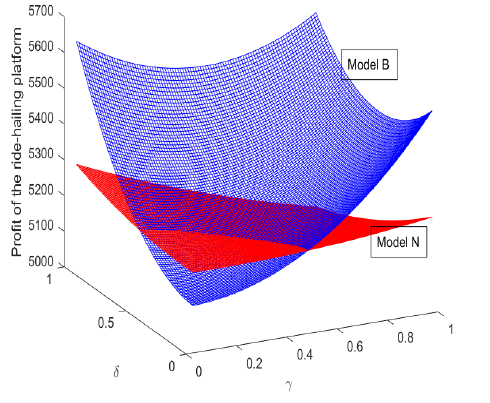
Figure 12. The sample for θ = 0.3 on γ − δ plane with π rn and π an